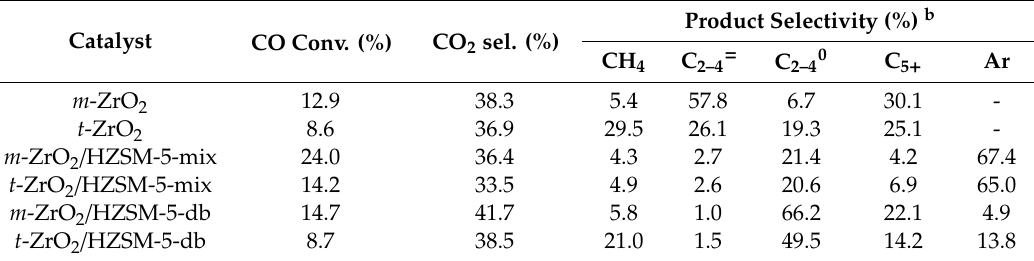
Table 3. Catalytic results over the ZrO 2 and ZrO 2 / HZSM-5 catalysts. a.